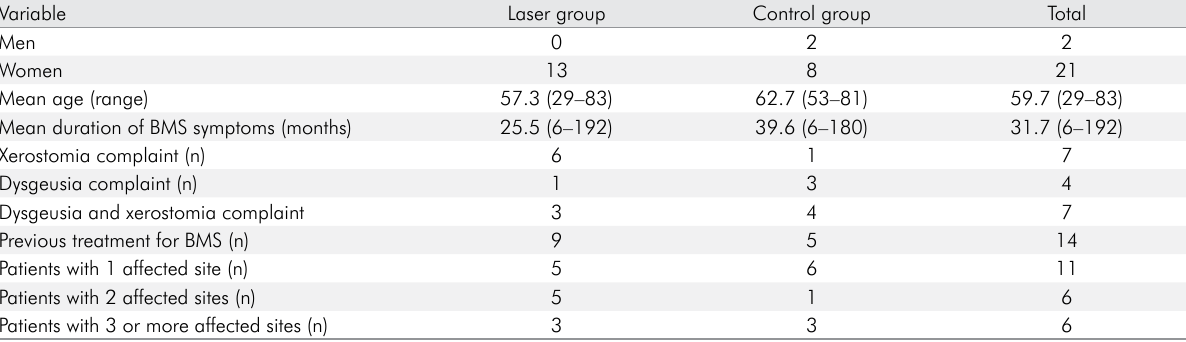
Table 1. Patients’ clinical profile.